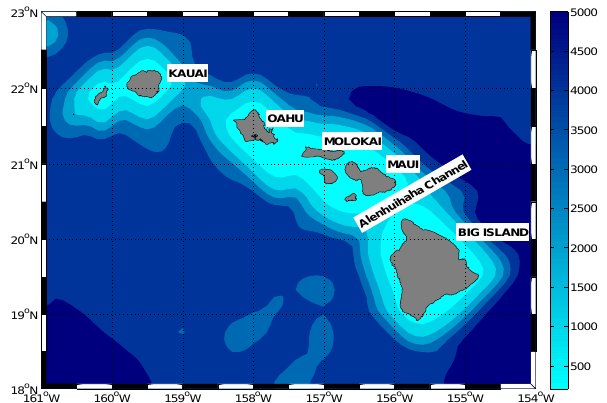
Fig. 1. Model domain and bathymetry [m]. Names of the islands and coastline at higher resolution are reported for geographical in- formation.